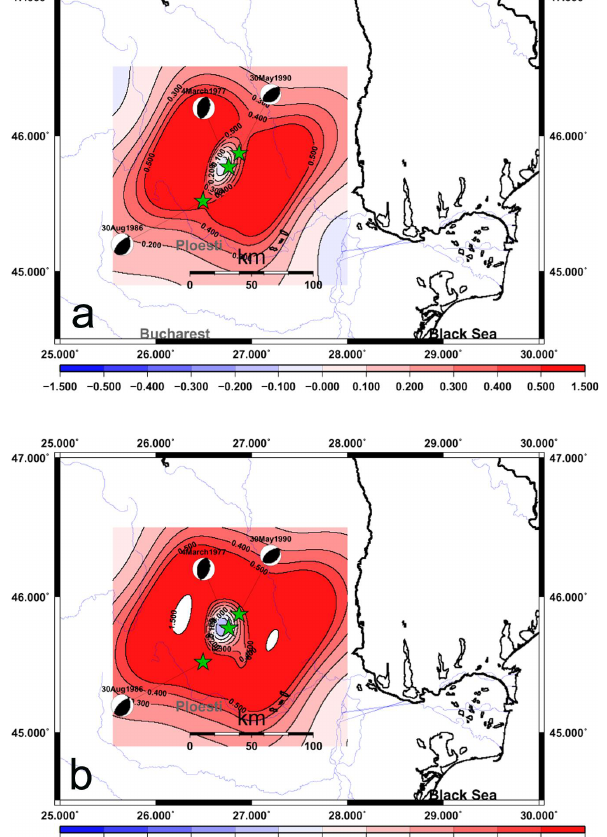
values imply pore fluid pressure inside the fault. So account- ing for pore pressure change ( 1P , Table 6, lines 3 and 6) we found again that Coulomb stress is